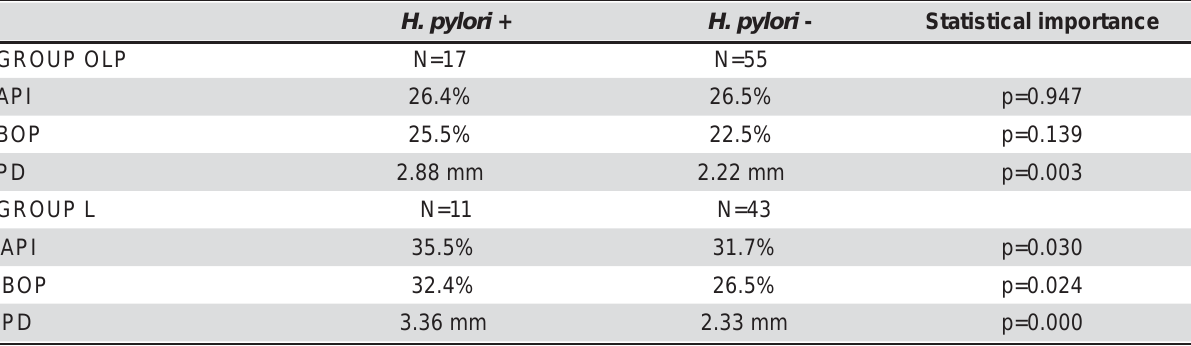
Table 2- Comparison of periodontal indices average values in OLP and L groups in patients with (+) and without (-) the presence of H. pylori